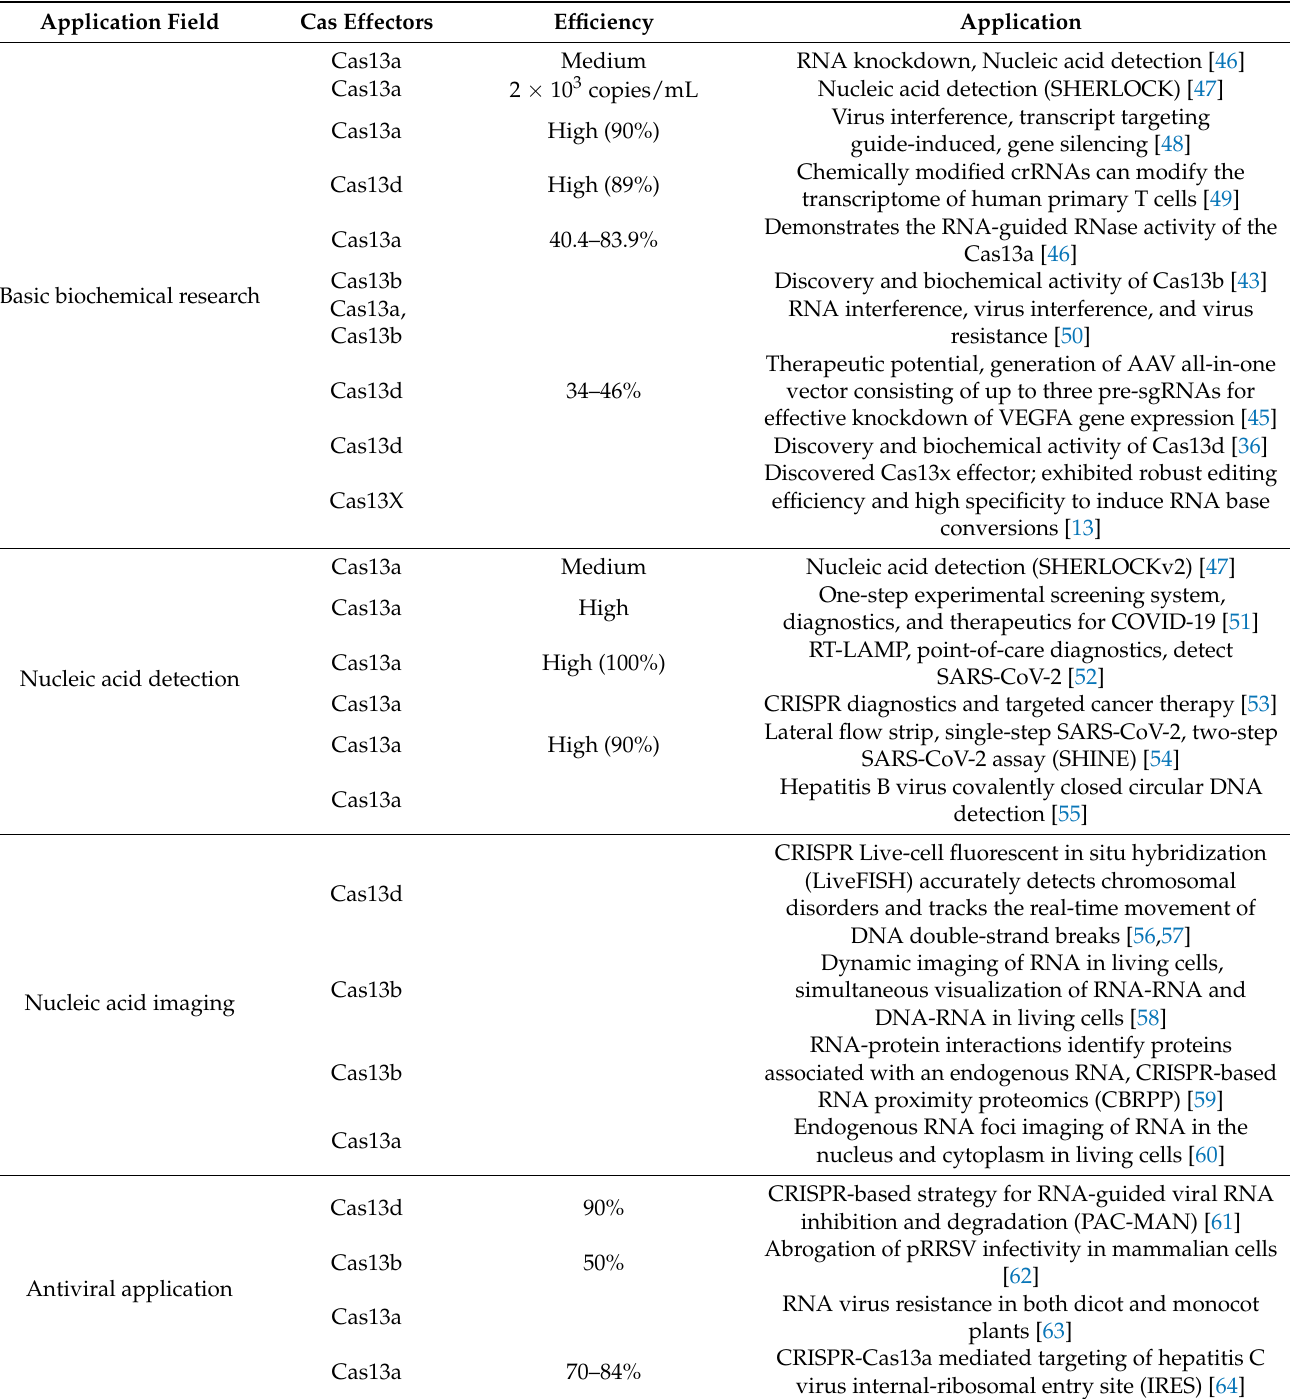
Table 3. Cas13-based RNA